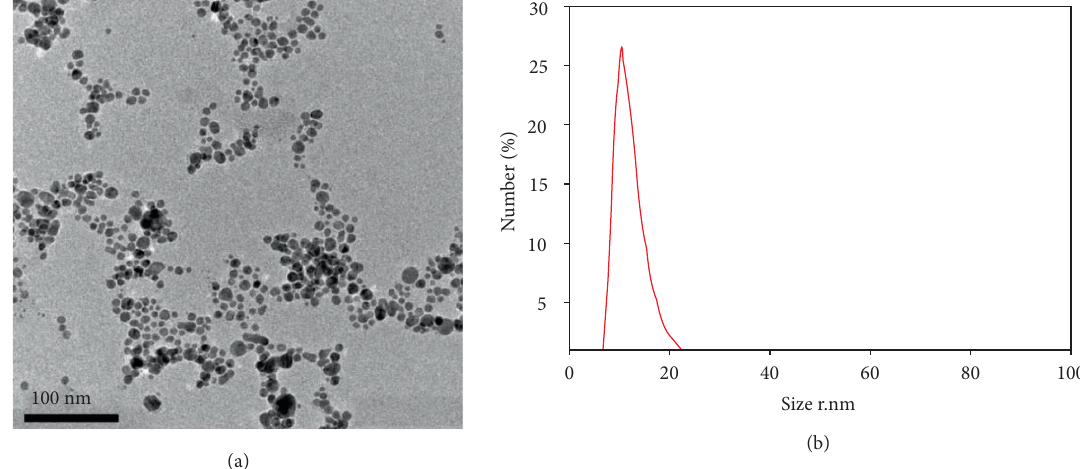
Figure 3: Silver nanoparticles biosynthesized by Cystoseira myrica . (a) HR-TEM images. (b) DLS